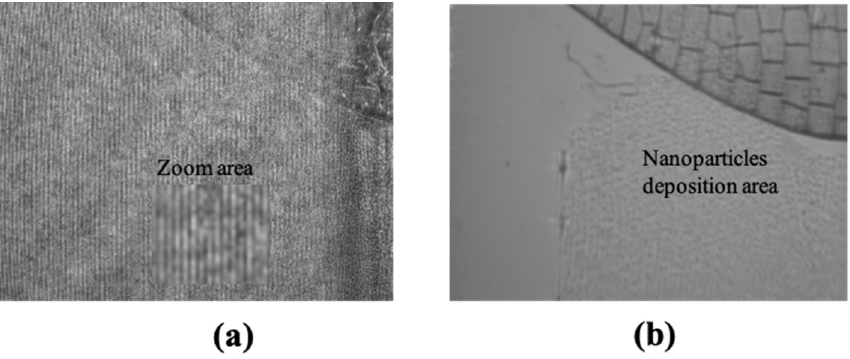
Figure 4. PLA nanoparticles deposited on a glass substrate. ( a ) Digital hologram obtained with the proposed microscope and ( b ) photograph obtained with the same camera using white light.